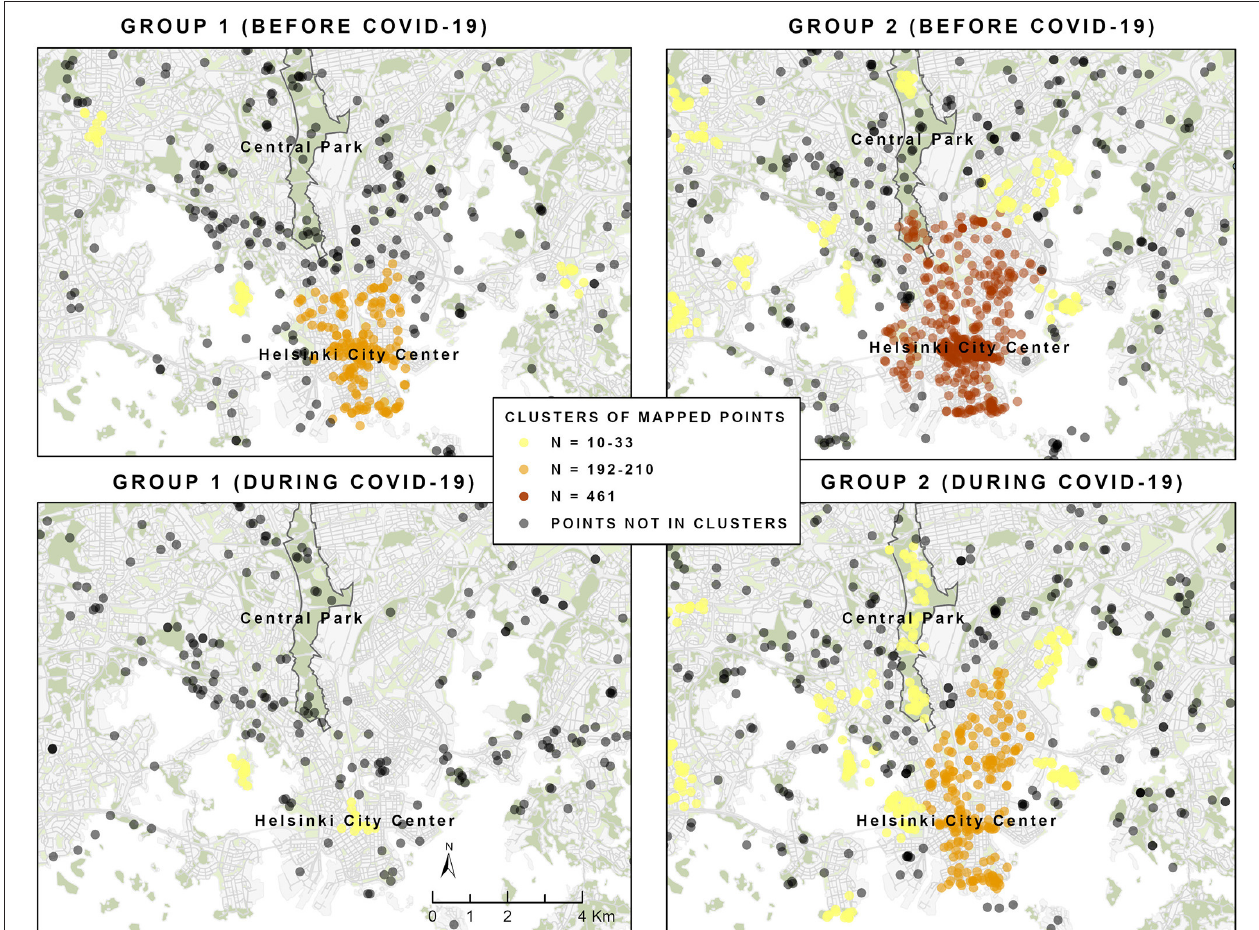
FIGURE 3 | A close up map of Helsinki’s city centre showing the density-based clusters of mapped recreational places identified for the two groups of respondents. Different clusters and their sizes are represented by different colours. Points not in clusters refers to the number of sparse points, not part of any clusters.